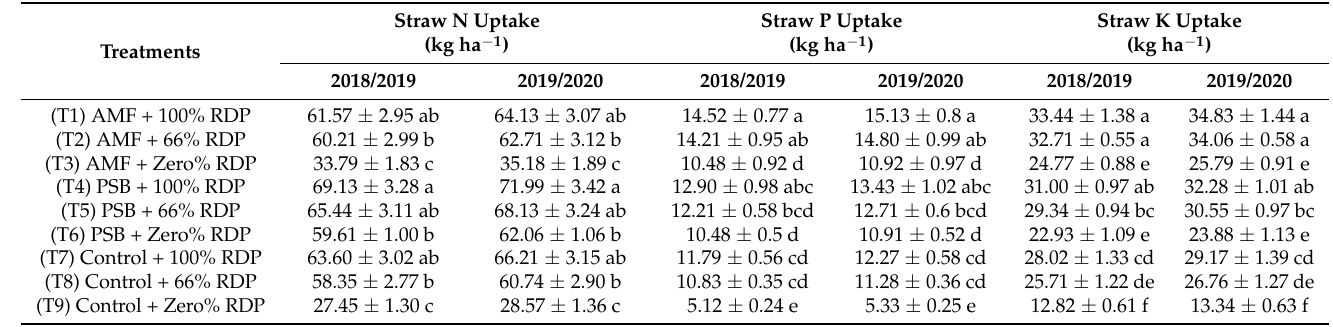
Table 6. Nitrogen, phosphorus, and potassium uptake of Giza 123 barley cultivar as influenced by the treatment of arbuscular mycorrhizal fungi (AMF), phosphate-solubilizing bacteria (PSB), and different percentages of the recommended dose of phosphorus fertilizers (RDP) in the 2018/2019